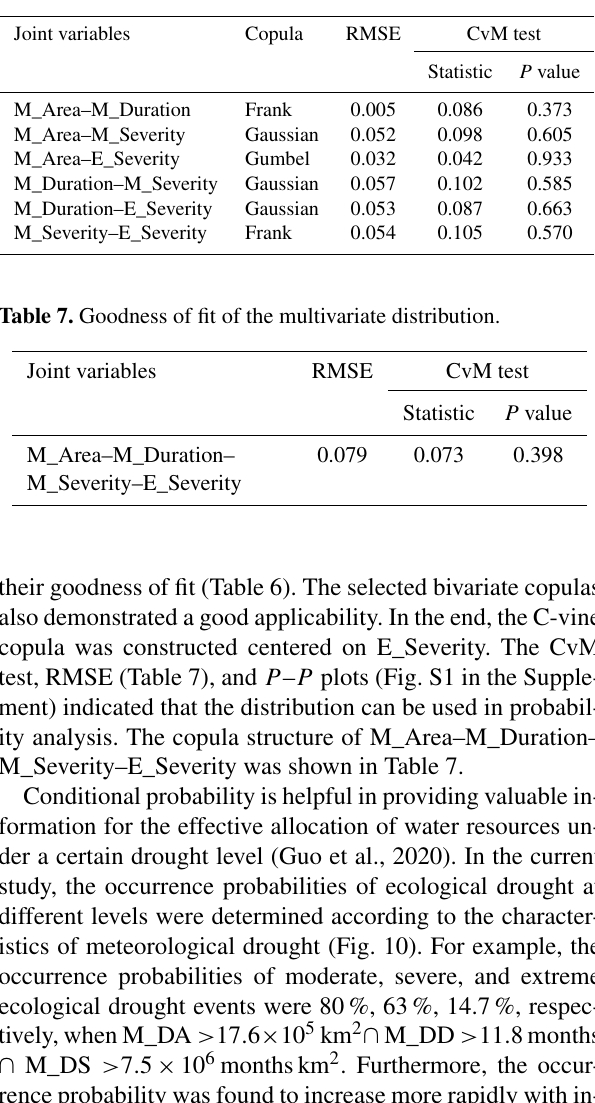
Table 6. Goodness of fit of the bivariate distribution.